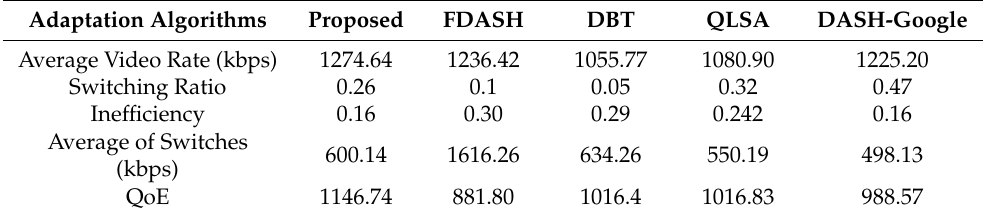
Table 9. Average performance of the algorithms over all the experiments.